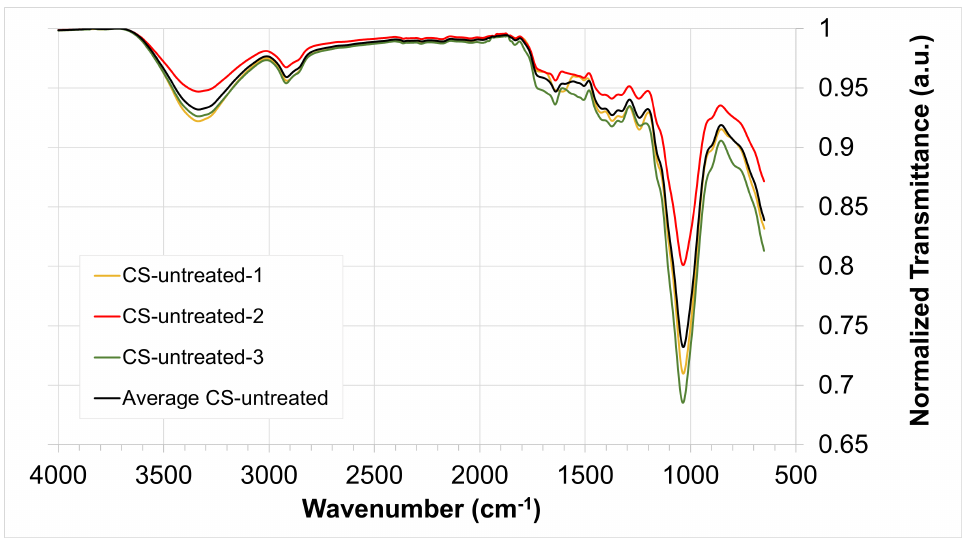
Figure 1. FTIR profiles of corn stover without pretreatment. Samples presented were ran in triplicates and averaged.